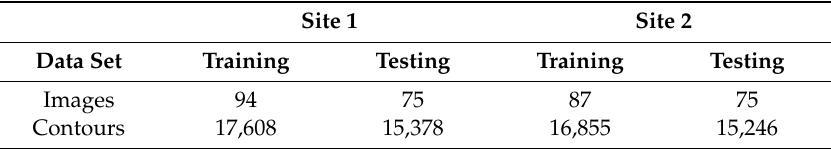
Table 2. Data sets used for training and testing of the